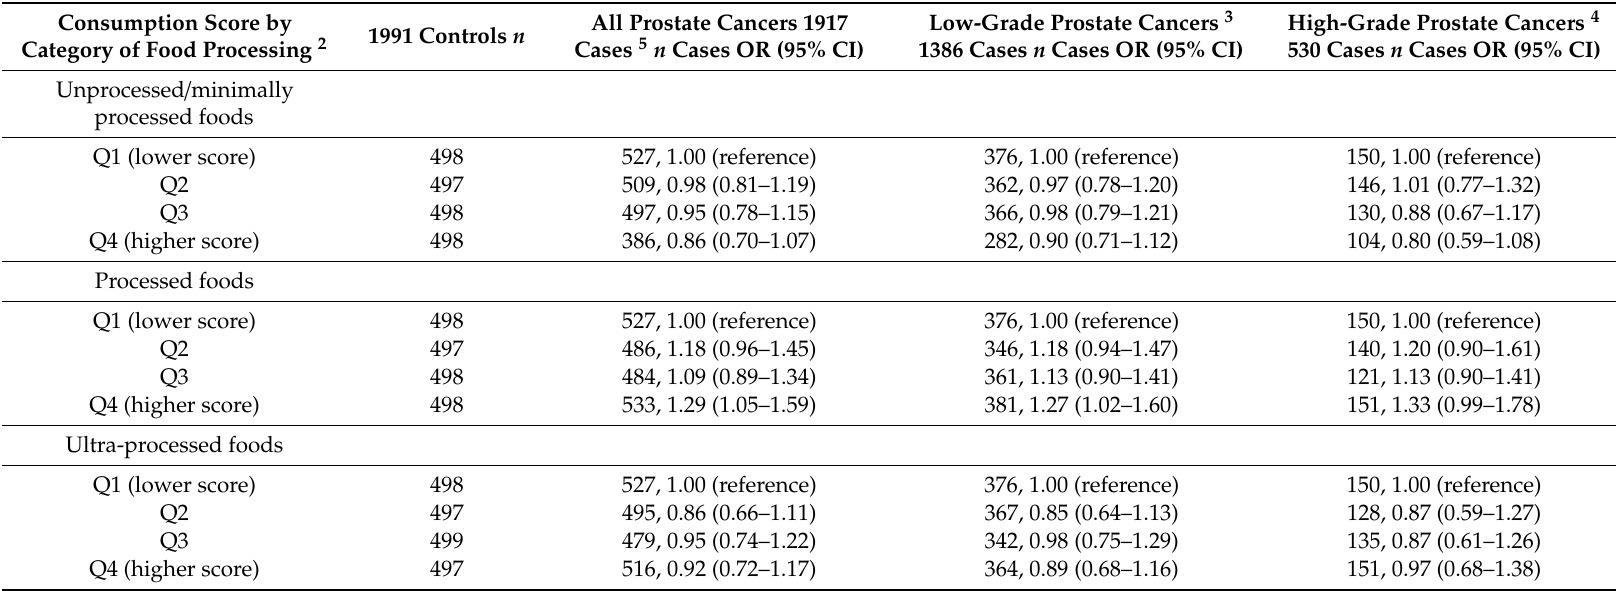
Table 3. Adjusted 1 odds ratios (ORs) and 95% confidence intervals (CIs) for the association between food processing scores and prostate cancer risk in PROtEuS, Montreal, Canada